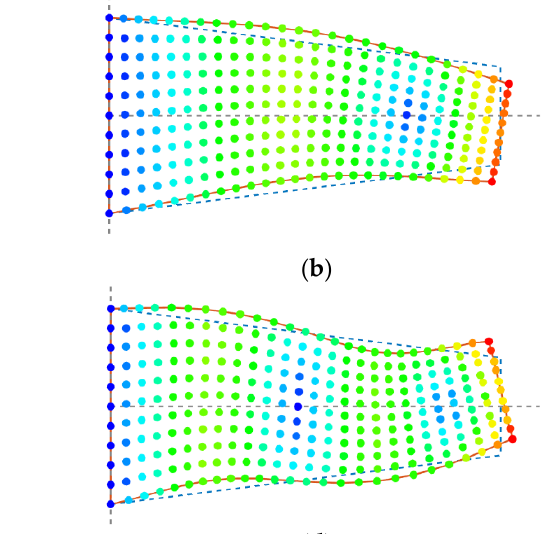
Figure 4. Eigenmodes for the variable-cross-section beam by the mixed MLPG5 method. ( a ) Mode 1; ( b ) mode 2; ( c ) mode 3; ( d ) mode 4.